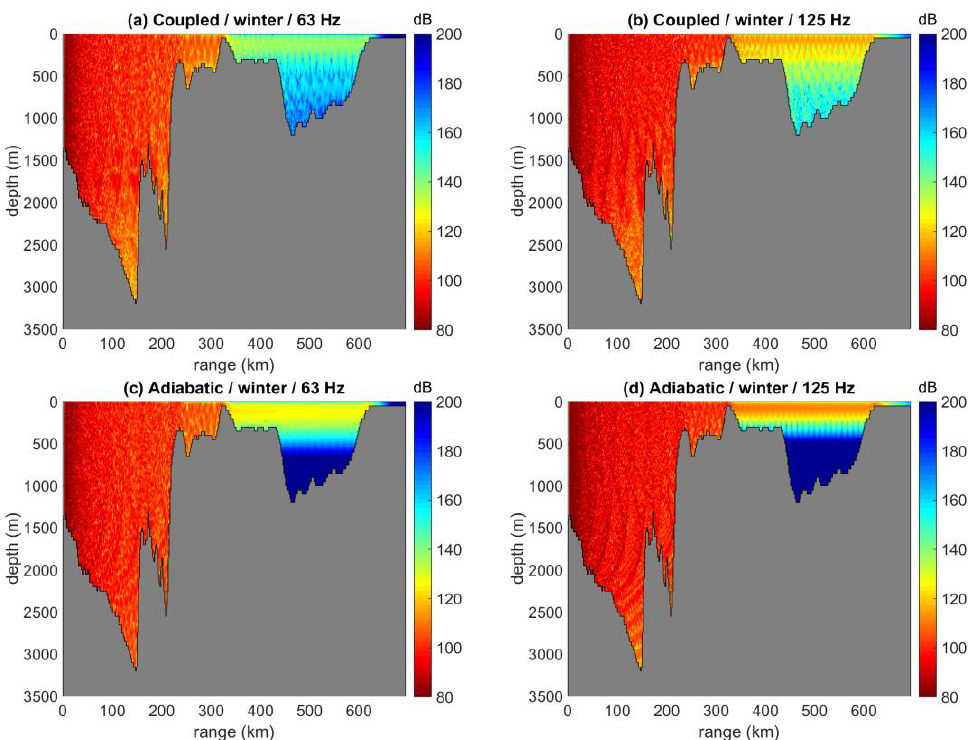
Figure 8. Transmission loss (dB) along transect CD for the winter SVP for a source depth of 5 m. ( a ) Coupled-mode results at 63 Hz; ( b ) Coupled-mode results at 125 Hz; ( c ) Adiabatic results at 63 Hz; ( d ) Adiabatic results at 125 Hz.